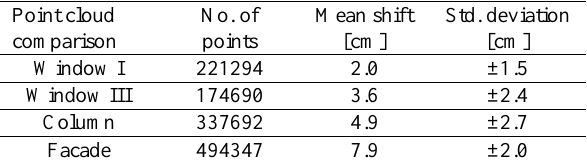
Table 4. C2C computations for the different parts of the building of the point cloud before filtering